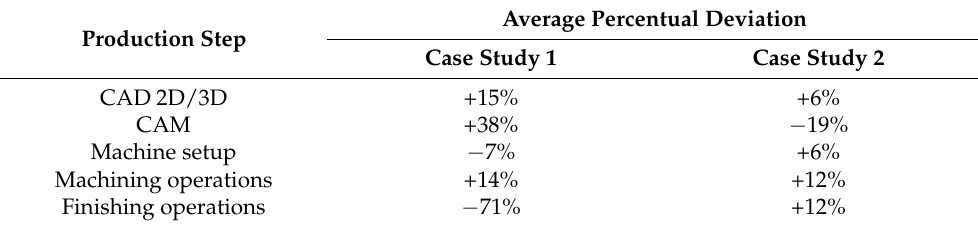
Table 9. Average percentual deviations for each of the production steps, for both case